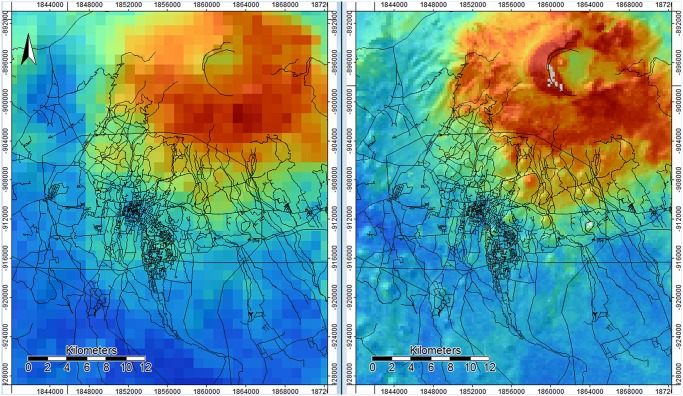
Predicted soil organic carbon content in permilles (depth: 0–5 cm) with a zoom-in on the area around the town of Arusha (Tanzania).(left) original SoilGrids1km layer at 1 km resolution vs (right) downscaled spatial predictions at 250 m resolution. Vector lines data source: OpenStreetMap.